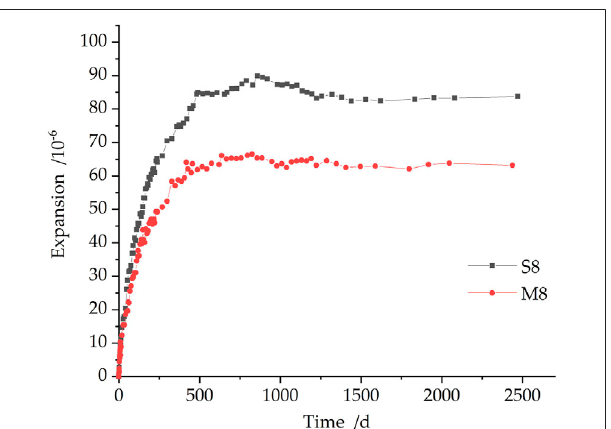
FIGURE 2 | Autogenous volume deformation of long-aged concrete without the MgO content at different specimen sizes.